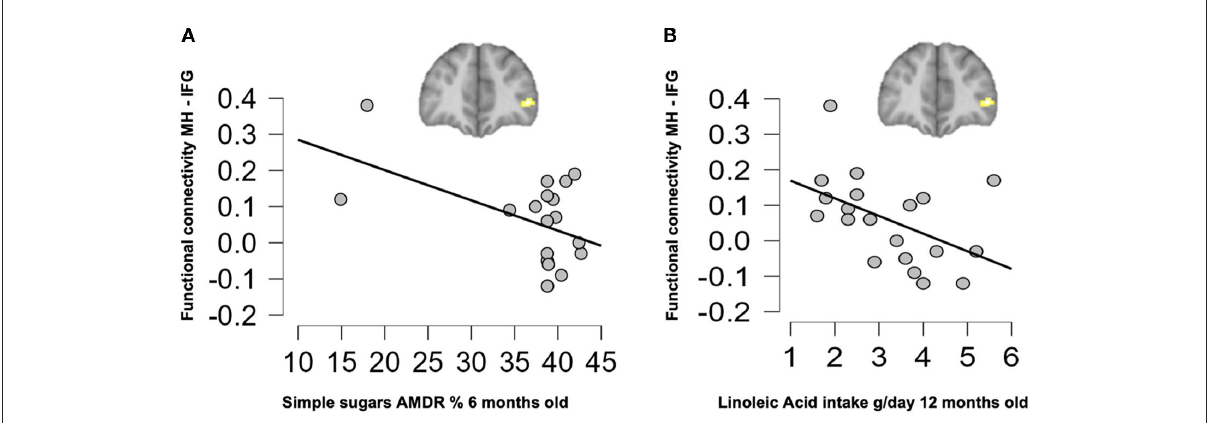
FIGURE4 Associations between resting-state functional connectivity at 6 years old and early nutrition at 6 months (A) and 12 months (B) of age in the BF group. AMDR, acceptable macronutrient distribution ranges; BF, breastfed; IFG, inferior frontal gyrus; MH, medial